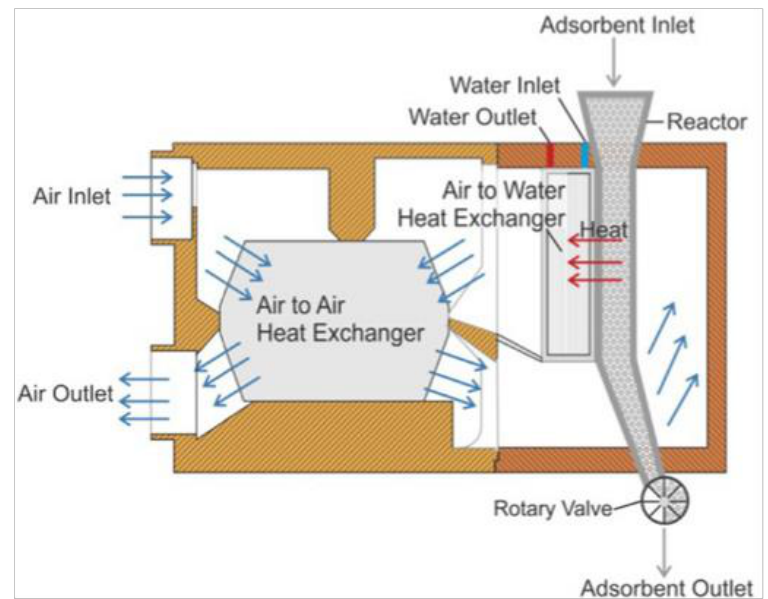
Figure 4. Example of a transported open system with zeolite [10].